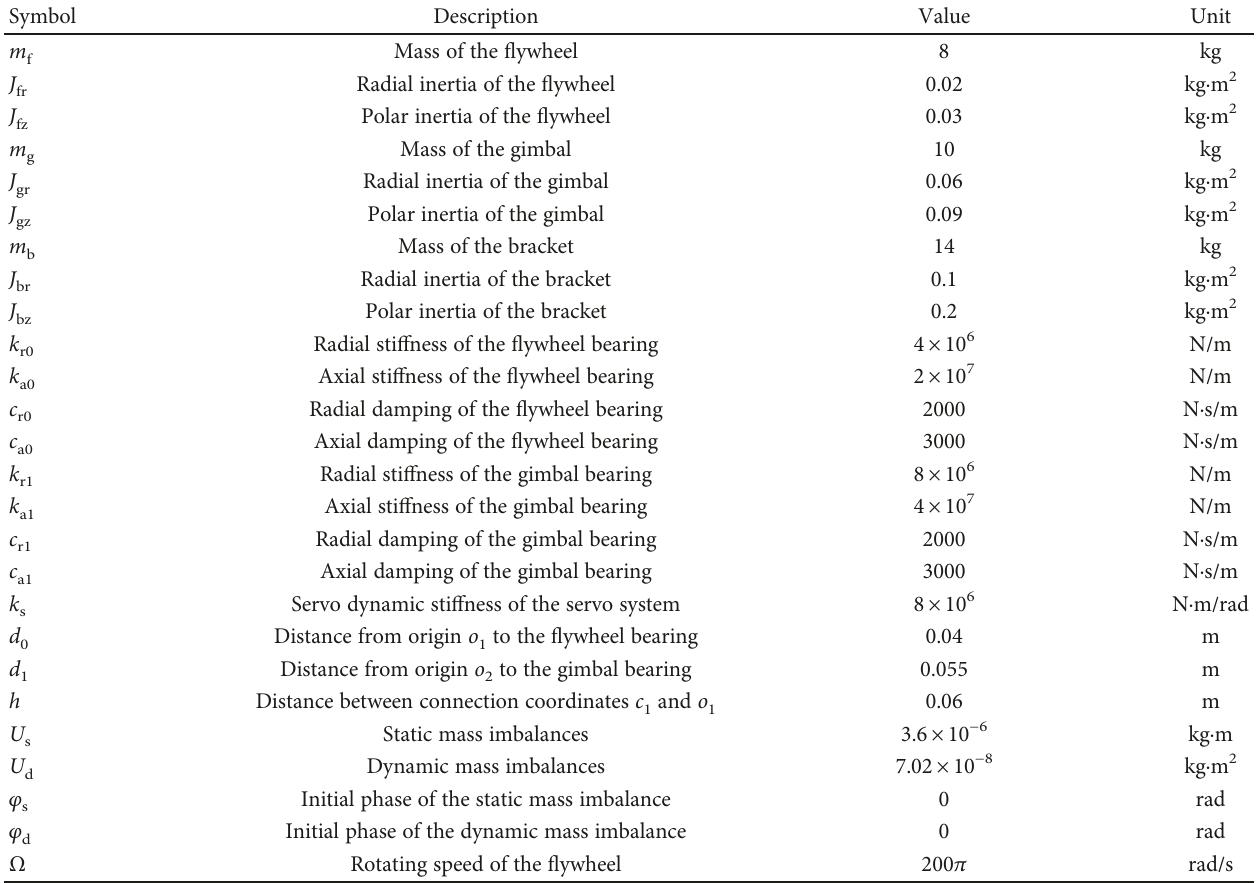
Table 4: Simulation parameters of the coupling